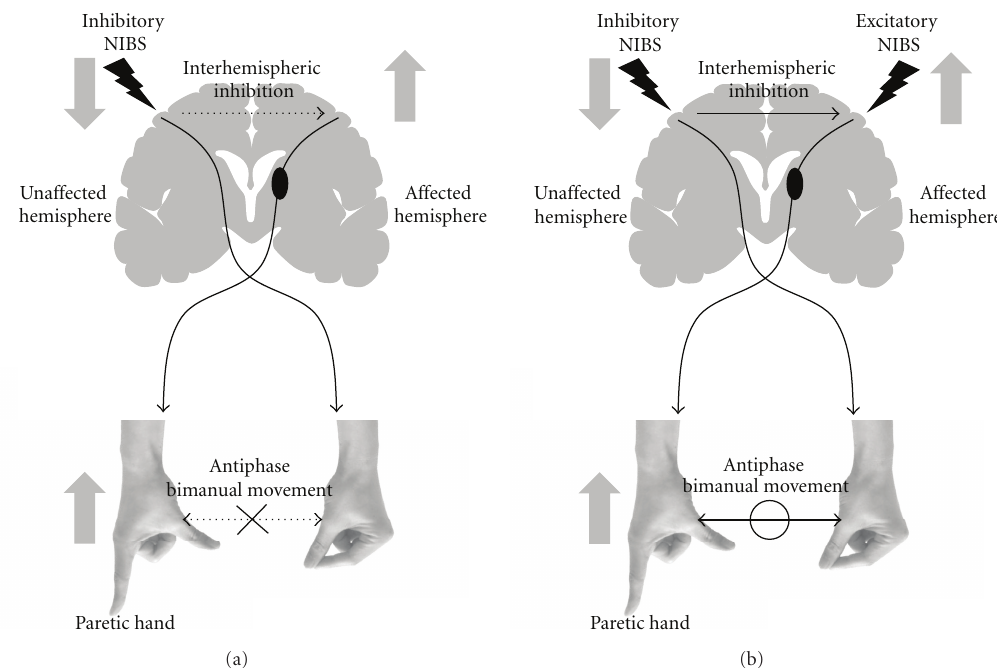
Figure 2: Mechanism of motor function change after noninvasive brain stimulation (NIBS) in stroke patients. (a) Inhibitory NIBS over the una ff ected hemisphere. Inhibitory NIBS decreases excitability of the contralesional motor cortex (M1) and increases excitability of the ipsilesional M1 by reducing interhemispheric inhibition from the una ff ected to the a ff ected hemisphere. Facilitation of the ipsilesional M1 improves motor function of the paretic hand in stroke patients. However, the antiphase bimanual movement deteriorates owing to the reduction of interhemispheric inhibition, which controls bimanual movement. (b) Bilateral NIBS. Excitatory NIBS along with inhibitory NIBS also decreases excitability of the contralesional M1, increases excitability of the ipsilesional M1, and improves motor function of the paretic hand in stroke patients. Bilateral NIBS lessens the reduction of interhemispheric inhibition induced by inhibitory NIBS and prevents deterioration of antiphase bimanual movement. Modified from Takeuchi et al.